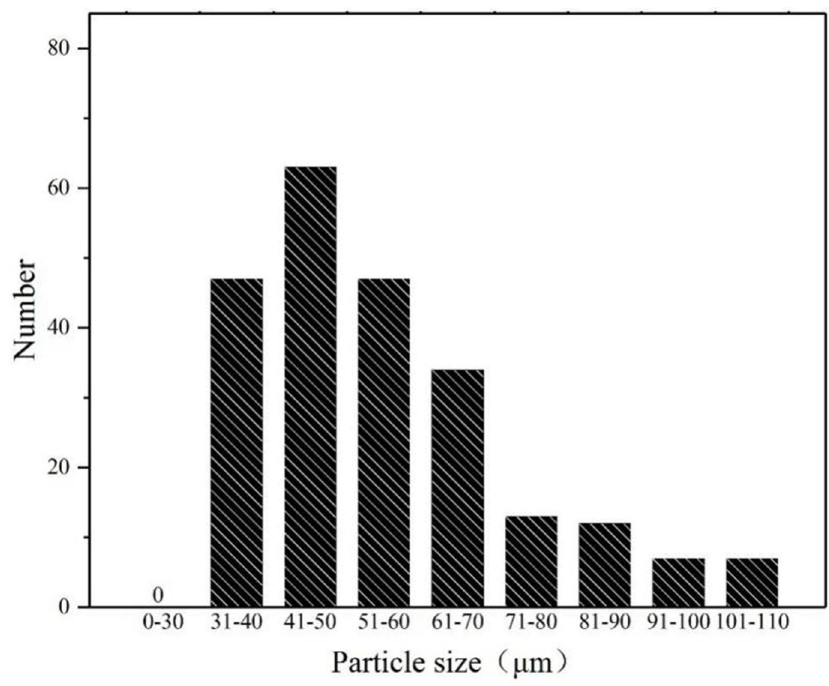
Fig 8. Average particle size distribution